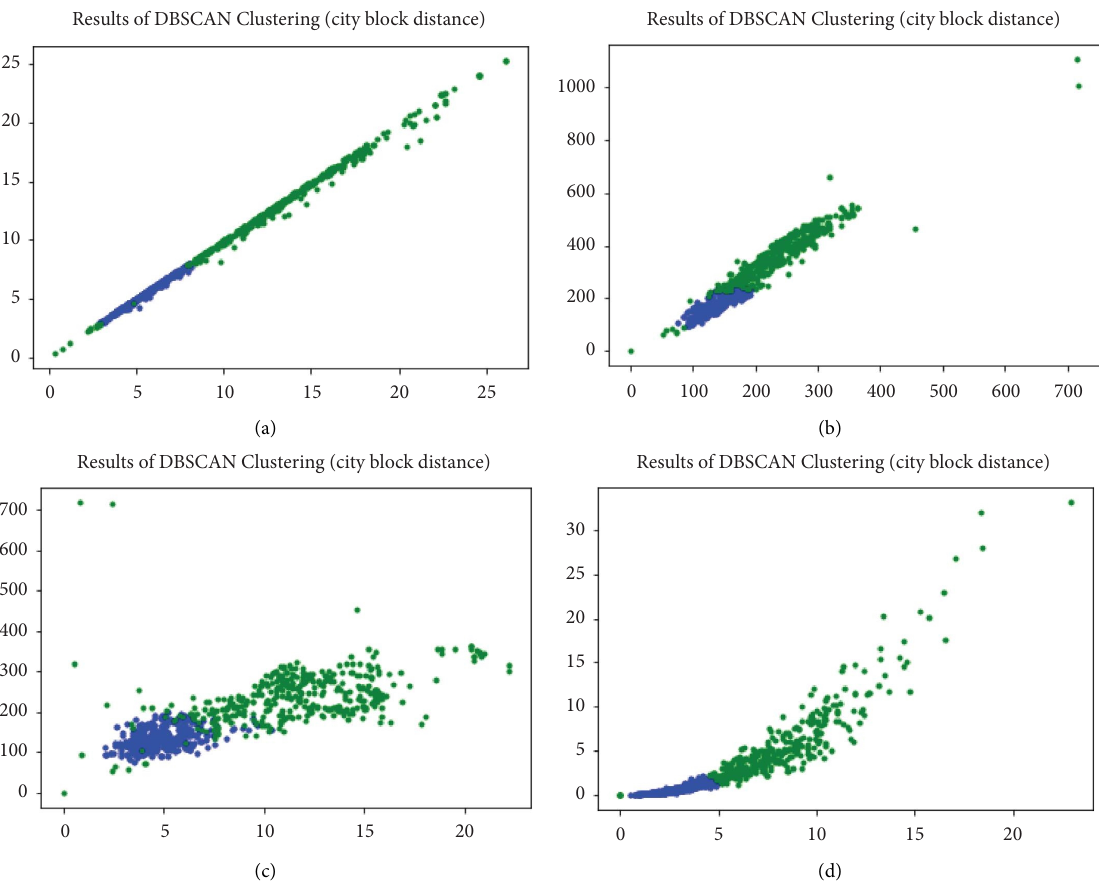
Figure 10: Clustering results of DBSCAN clustering (city block distance). (a) Feature vector f (d) feature vector f h